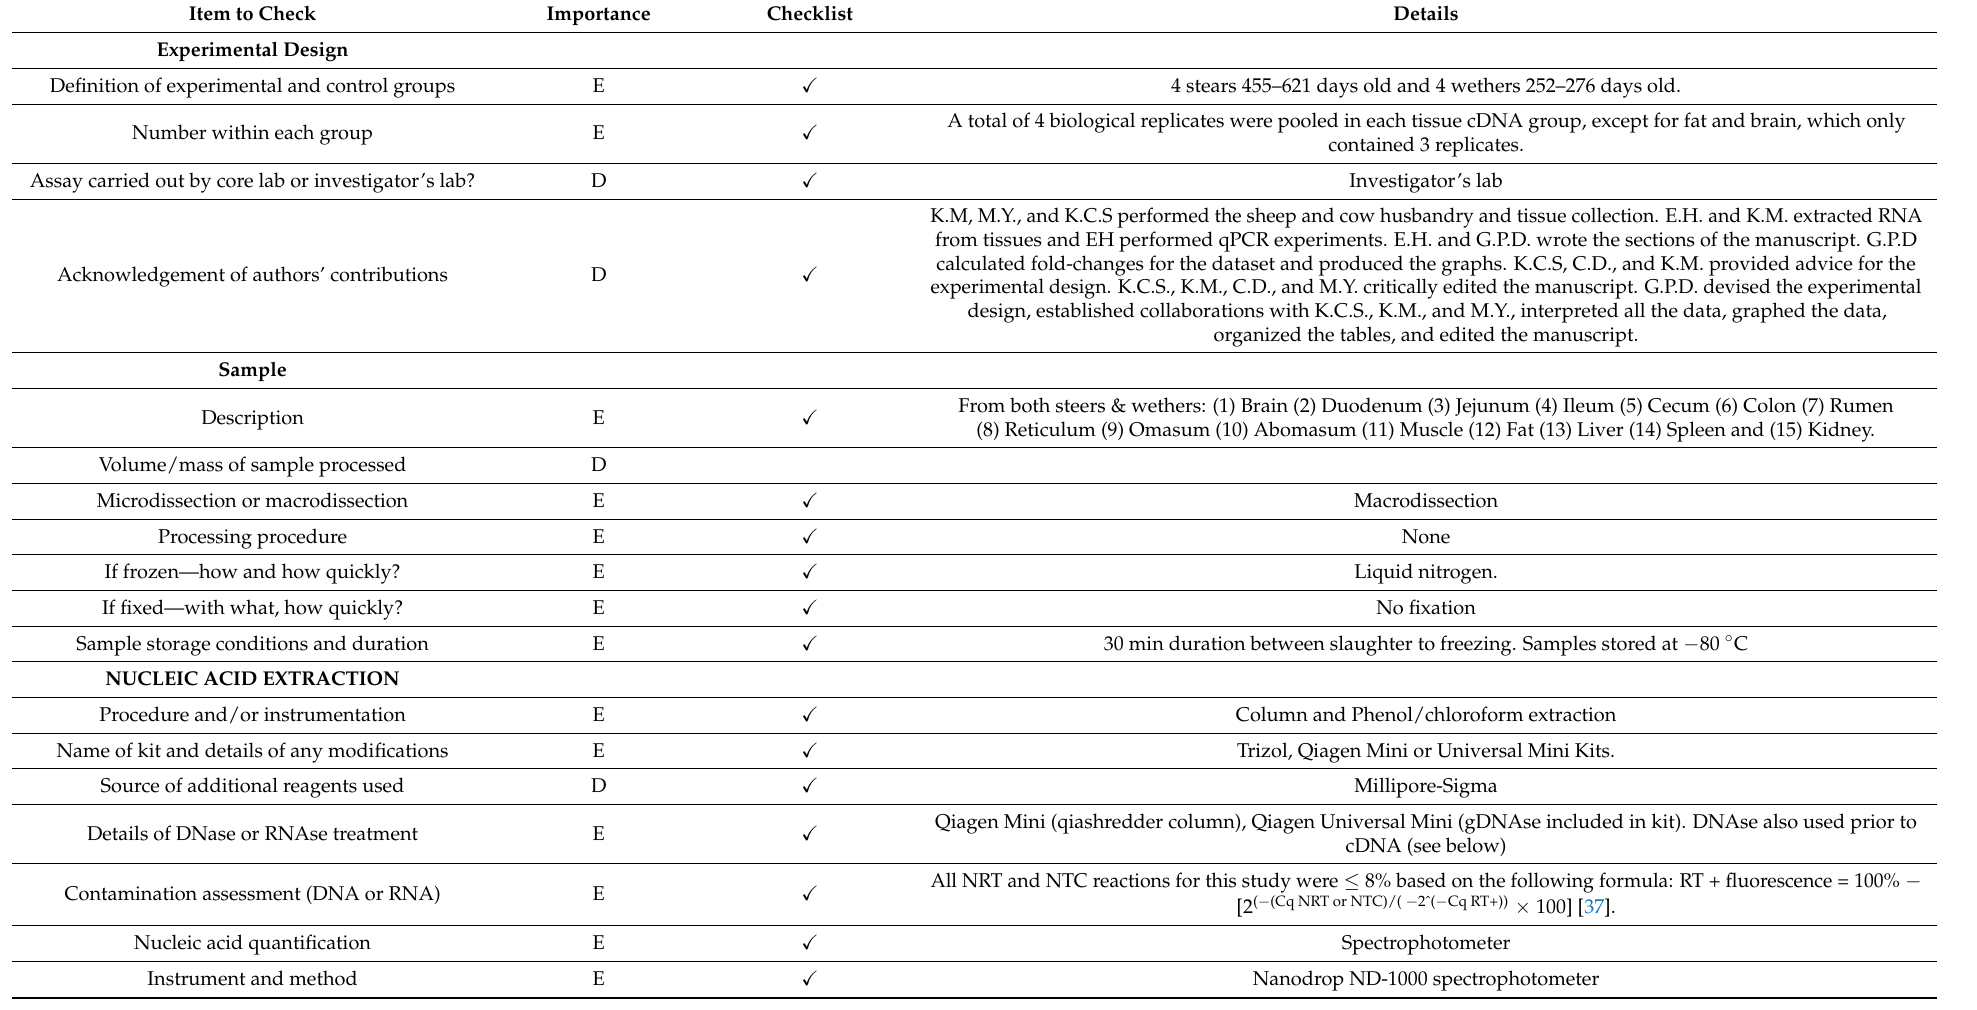
Table A1. MIQE Checklist. Descriptions of each parameter of the MIQE Checklist. E = All essential information. D = Desired Information that is submitted if